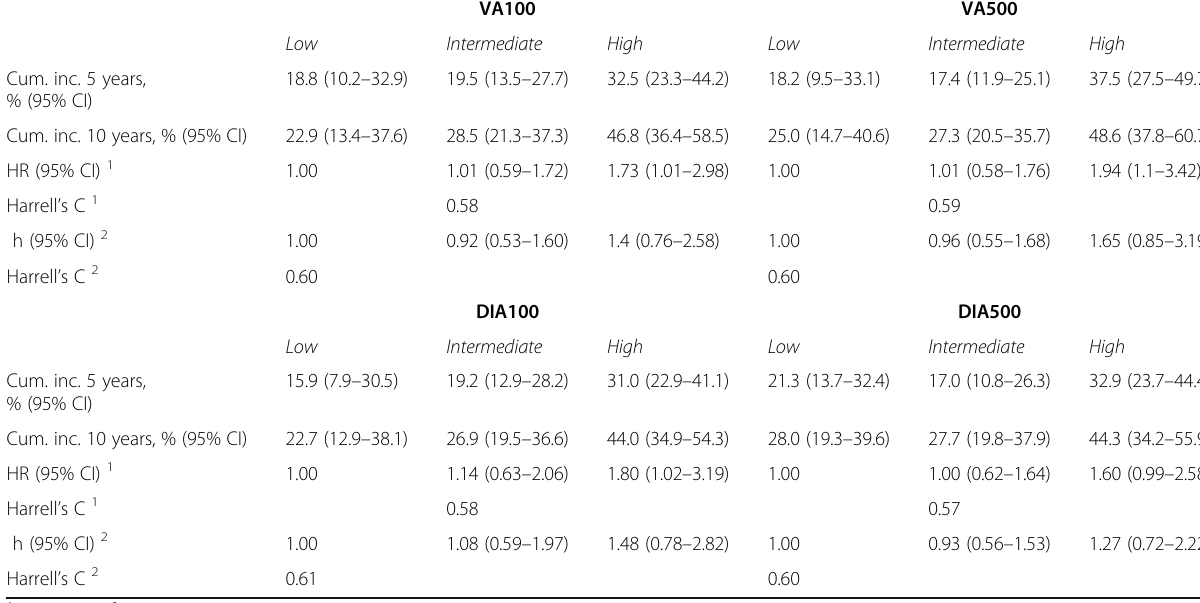
Table 2 Risk of death from breast cancer according to Ki-67 level and counting procedures, expressed as cumulative incidence and hazard ratios of death from breast cancer VA100 VA500 Low